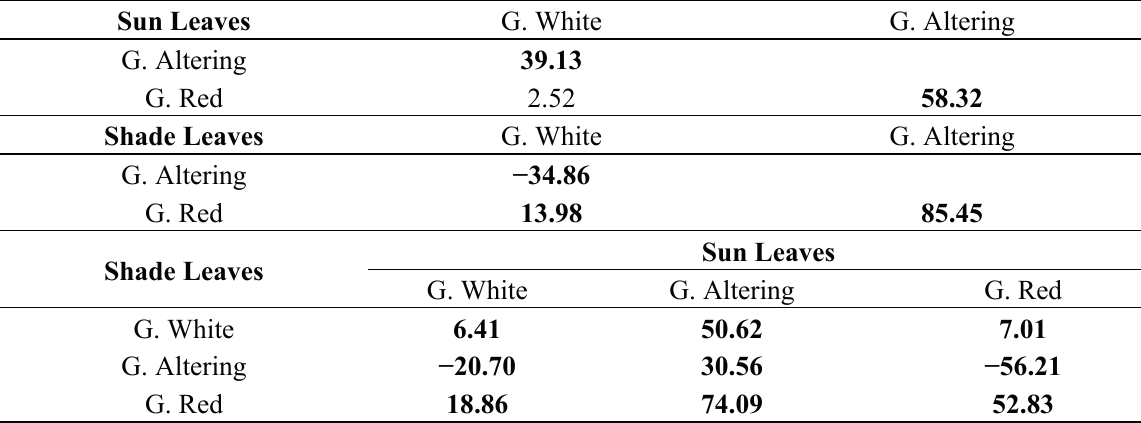
Table 2. Comparison of total polyphenolic contents in Gohér varieties. Data are actual t -values, corresponding to the total amount data in Table 1, for analysis between grapevine varieties within sun exposure. Significant differences at p ˂ 0.05 indicated in